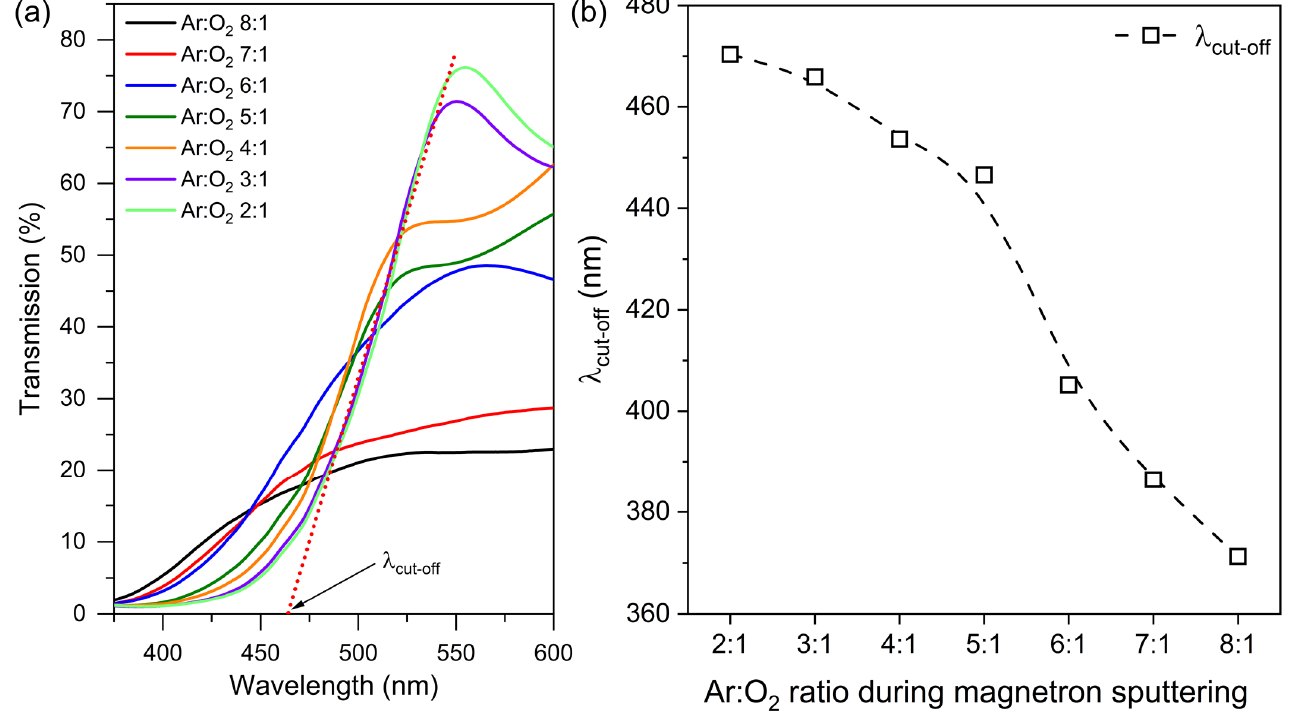
Figure 5. Results of ( a ) the determination of the fundamental absorption edge on a sample prepared